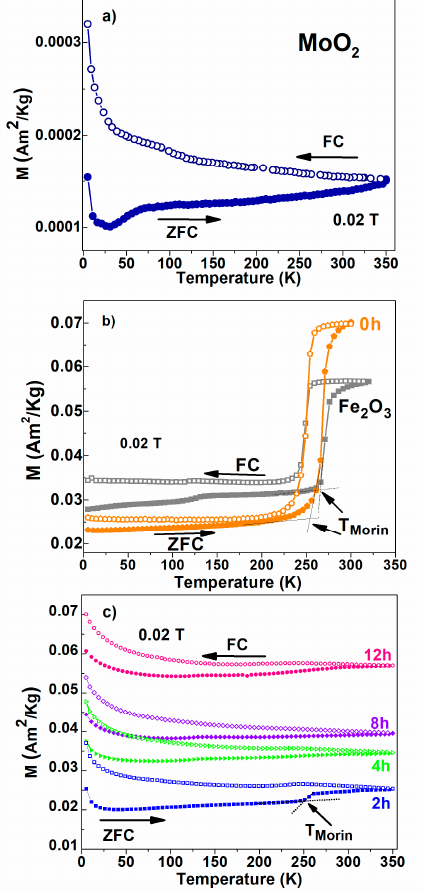
Figure 2. ZFC–FC thermomagnetic measurements, recorded in 200 Oe applied magnetic field (0.02 T magnetic induction), for ( a ) MoO 2 and ( b ) Fe 2 O 3 and for the powder mixture manually ground (0 h), ( c ) for samples obtained after 2, 4, 8, and 12 h milling times.